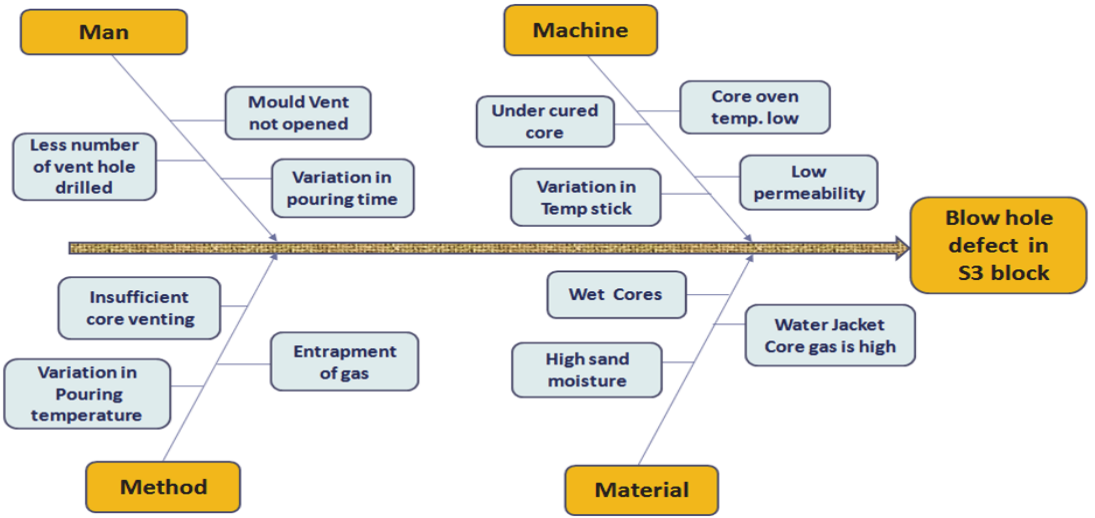
Fig. 5. Cause & Effect diagram – Blow holes